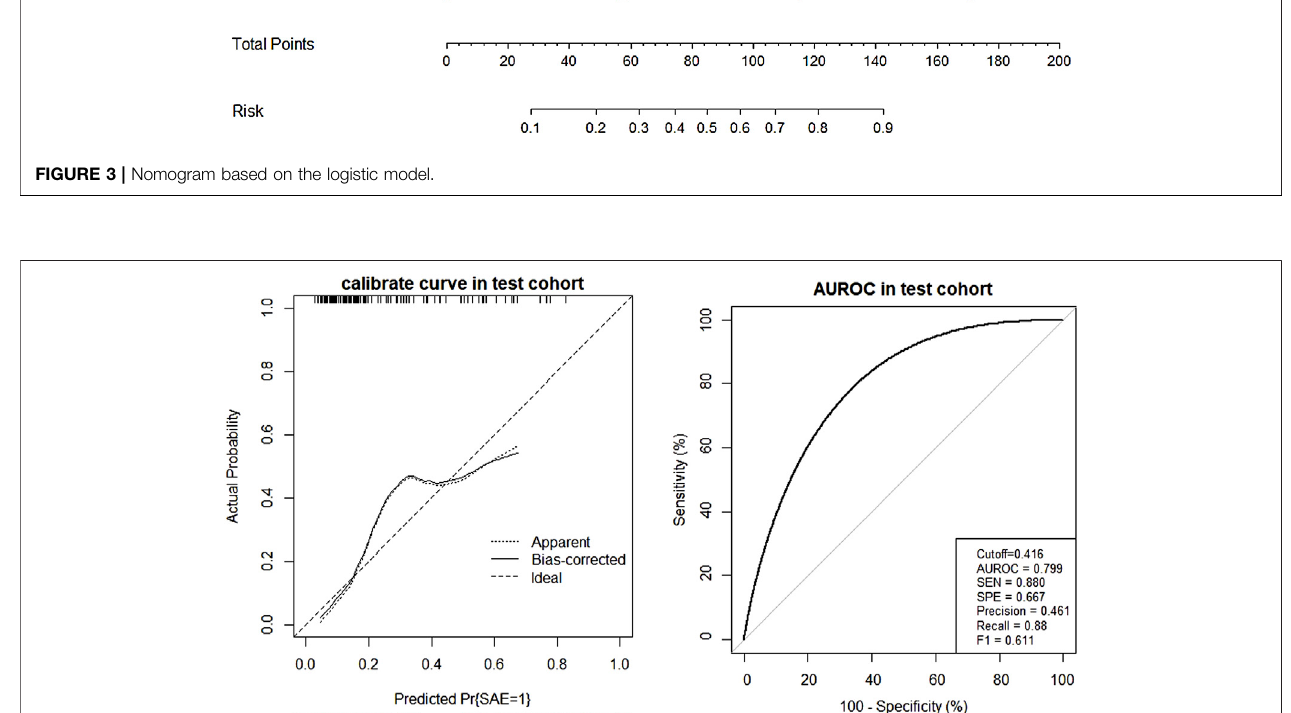
FIGURE 4 | Nomogram calibration curve and AUROC in the test cohort.